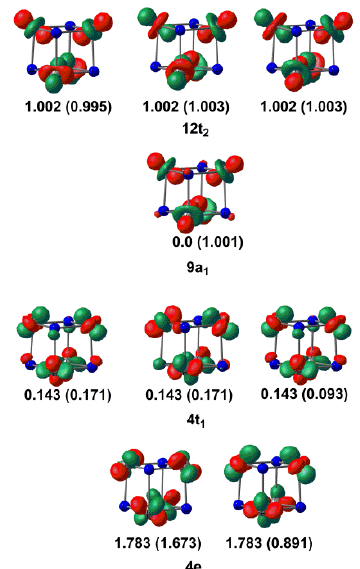
Figure 3. Natural orbital occupations for the 4 A 2 and 6 A 1 states (in parentheses) of [V 4 N 4 ] + with a (7,9) complete active space.